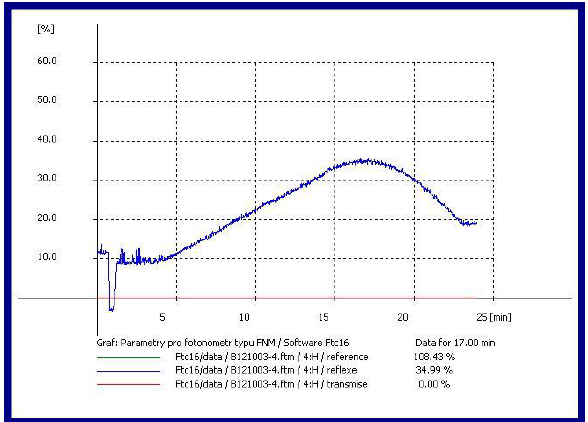
Fig.8. An example of the graphic result from coating